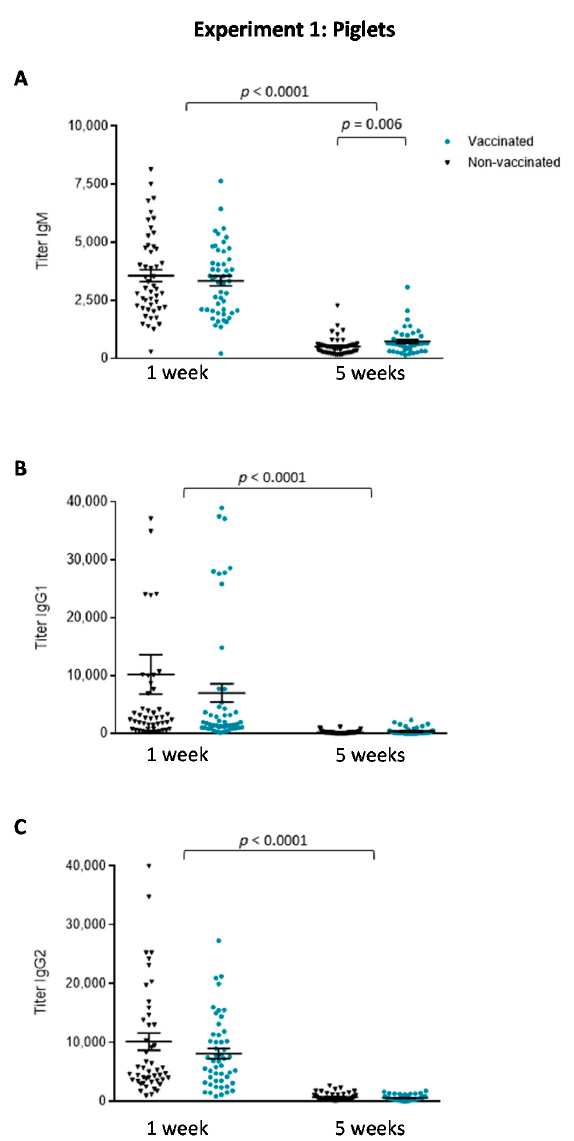
Figure 3. Experiment 1: Isotype profile of antibodies against S. suis serotype 7 in piglets. Blood samples were collected from randomly chosen (and tagged) piglets at one and five weeks of age from 50 vaccinated and 50 non-vaccinated (including the 20 placebos) animals to evaluate: ( A ) IgM titers; ( B ) IgG1 titers; and ( C ) IgG2 titers by ELISA. The vaccination protocol is shown in Figure 1. Antibody titers for individual piglets are shown with horizontal bars representing mean ± SEM. Values significantly different are shown in the graph with corresponding p value.